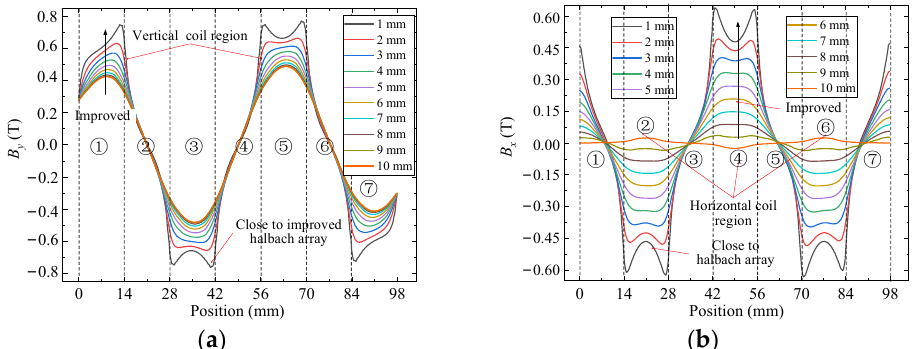
Figure 13. Airgap flux density distribution of conventional halbach array scheme: ( a ) y component; ( b ) x component.